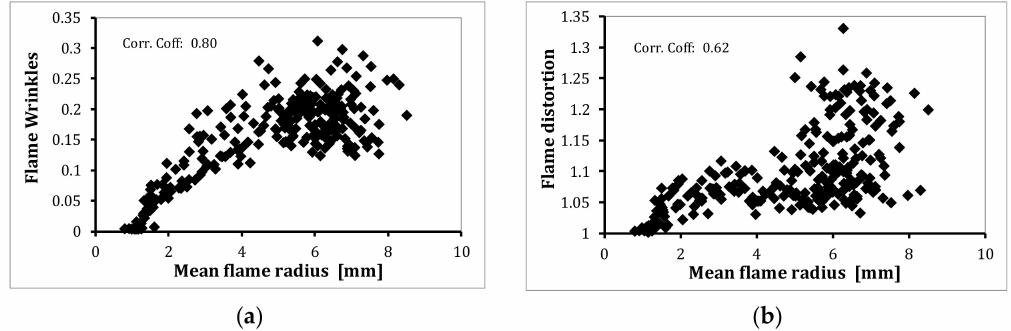
Figure 14. Correlations of flame wrinkles ( a ) and flame distortion ( b ) with mean flame radius.